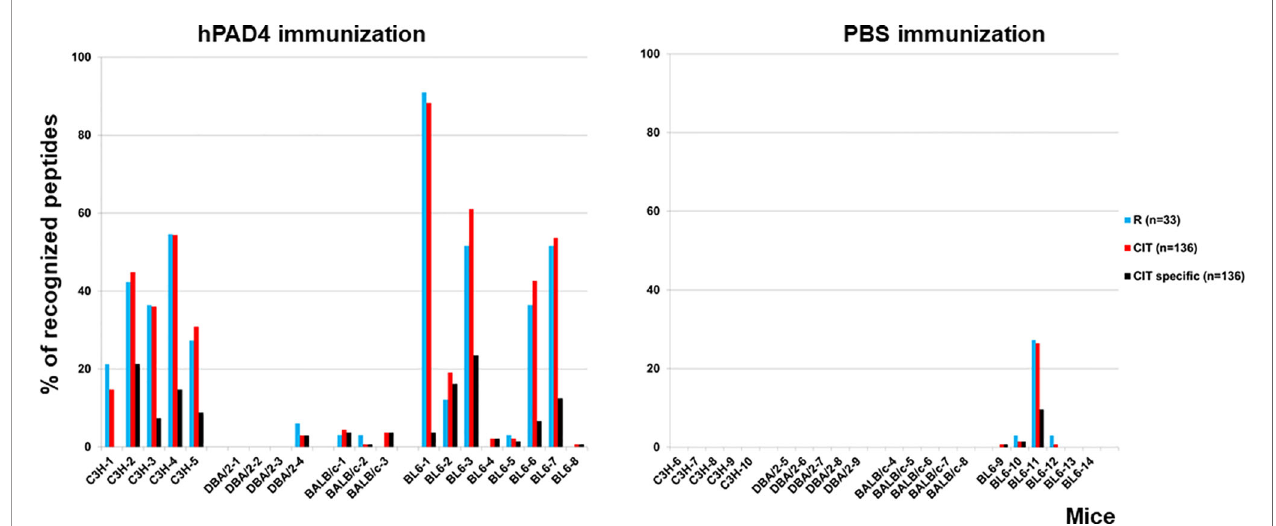
FIGURE 2 | Percentage of recognized peptides in C3H, DBA/2, BALB/c and BL6 mice immunized with hPAD4 or PBS. Peptide arrays made of 33 arginine-containing peptides and their 136 citrullinated variants were used to screen the sera of mice immunized with hPAD4 or PBS. For each strain, background mean signal intensity was obtained for each peptide using sera from mice immunized with PBS. A positive serum was de fi ned by a ratio (mean test signal/mean background signal) higher than